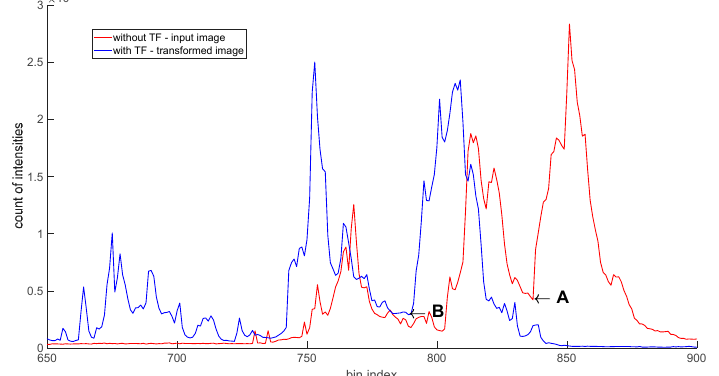
Figure 10. Histograms of BG/LD(Shapes) with and without the technical filter application.